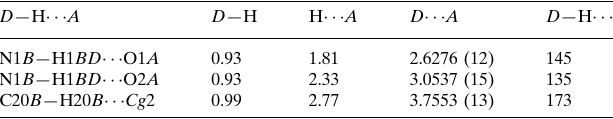
Hydrogen-bond geometry (A ˚ , (cid:4)